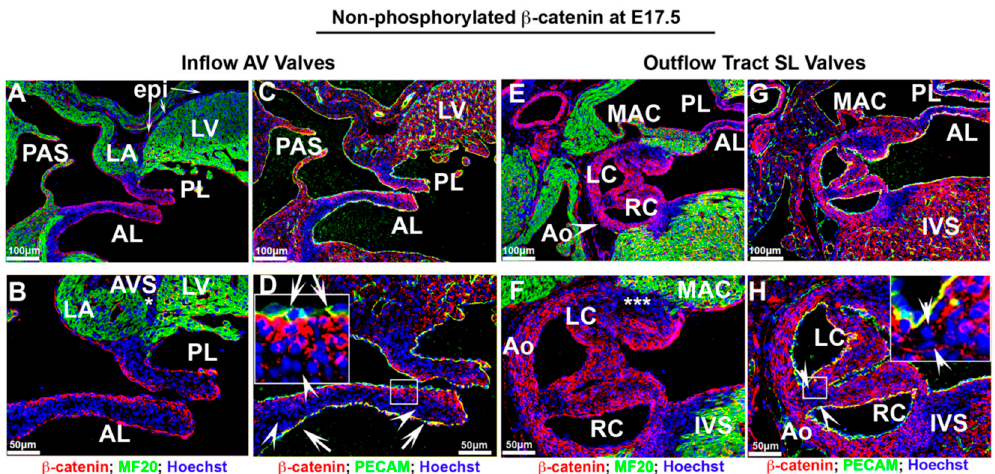
Figure 7. Membrane β -catenin expression at E17.5 fetal cardiac development. ( A – D ) . Membrane β -catenin was expressed prominently throughout the valve endocardium within the anterior, posterior mitral leaflets, ventricular endocardium and myocardium. Cells sub-adjacent to the atrialis endocardium of the mitral leaflets displayed positive staining with much less to undetectable expression within the rest of the mitral leaflets (( D )—arrowheads). Membrane β -catenin was undetectable on epicardial cells within the left ventricle or within the atrioventricular sulcus (( A , B )—asterisk). ( E – H ) Within the aortic valves, membrane β -catenin was evident on all endocardial cells and most interstitial cells as well as within the mitro–aortic continuity (MAC). A subset of cells within aortic wall adjacent to MAC had undetectable staining (( F )—asterisks). Membrane staining was not observed on interstitial cells within the hinge regions (( H )—boxed region).